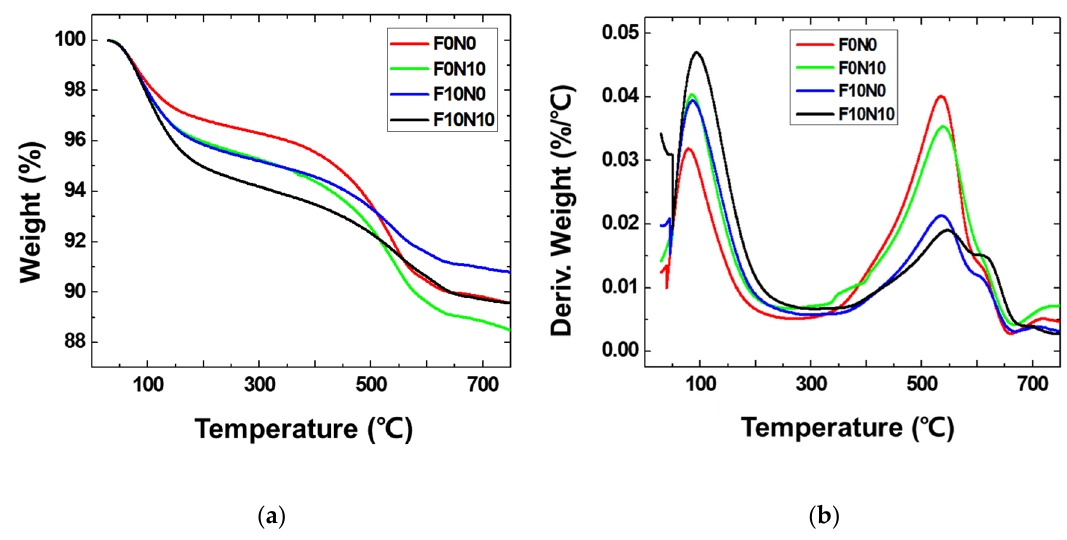
Figure 6. Results of thermal analyses of AAS specimens: ( a ) Thermogravimetric (TG) and ( b ) derivative TG (DTG).